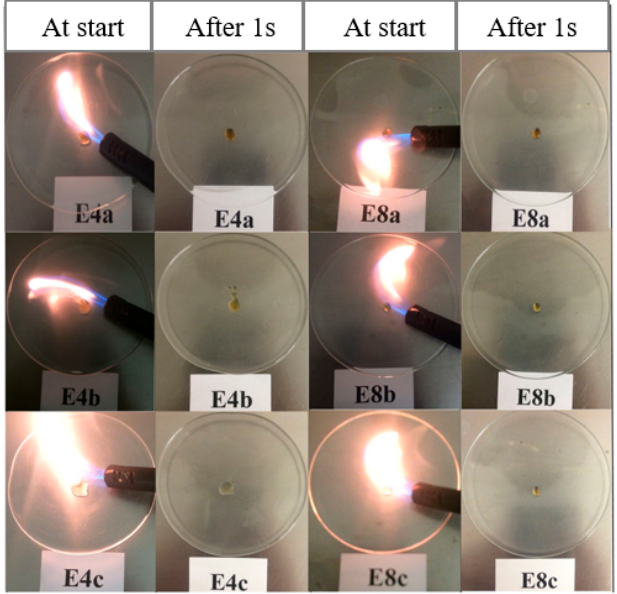
Figure 6. Development of the flames for different DIL-based electrolytes during SET test directly at the burner was turned on (at the start) and was turned off (after 1 s), respectively [54].